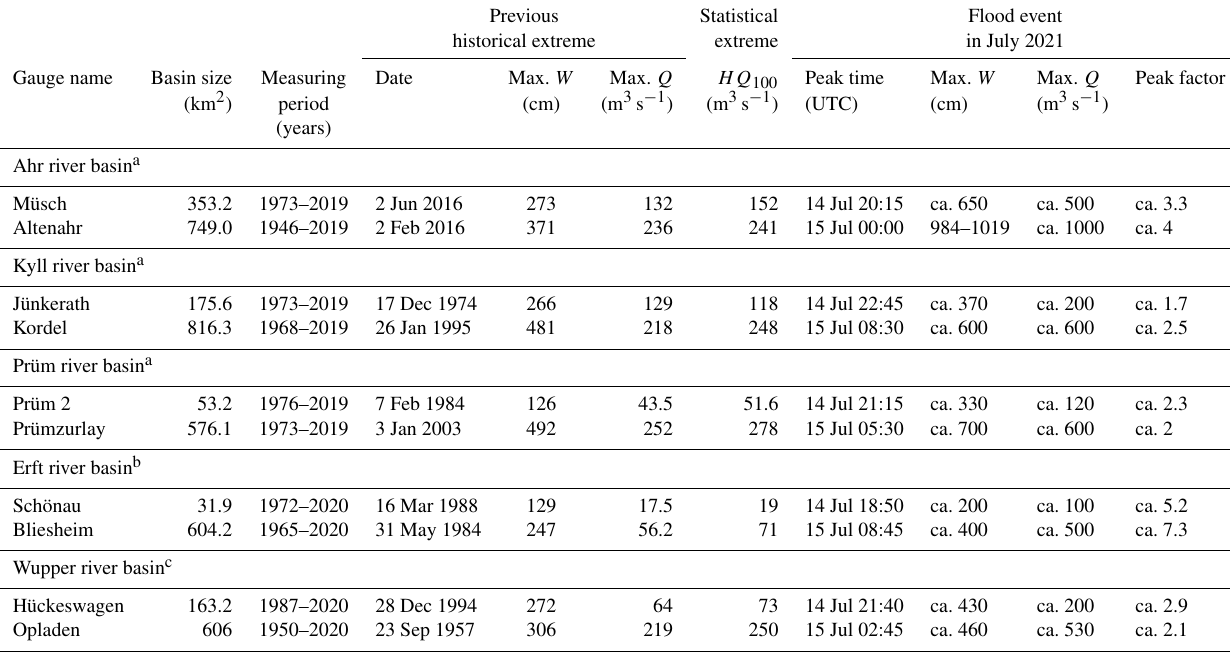
Table 1. Key characteristics of river basins and gauges (water level W ; streamflow Q ; HQ 100 means a flood with statistical 100-year return period; peak factor is defined as max( Q ) in 2021 divided by HQ 100 ) including statistics of previous historical extremes and the July 2021 flood event. Values for the latter are approximations